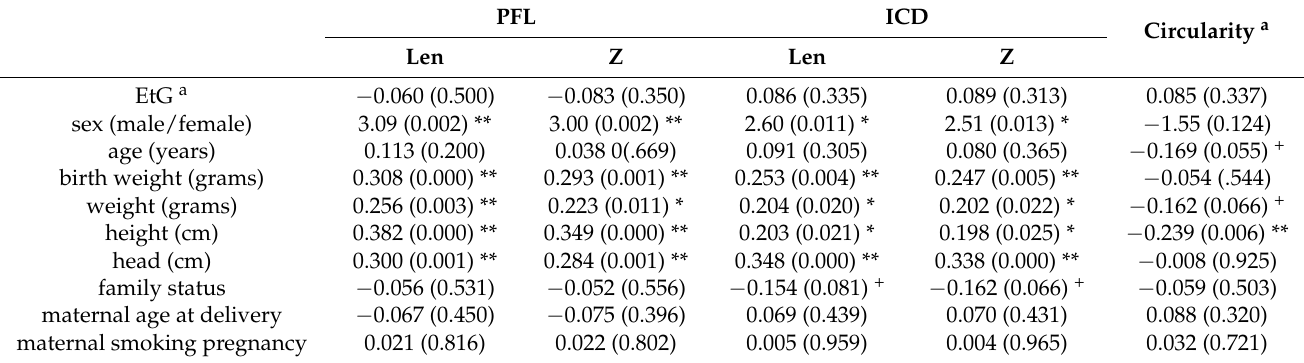
Table 3. Testing potential confounders in Pearson’s correlations and t -tests (r/t( p )), n = 129. PFL ICD